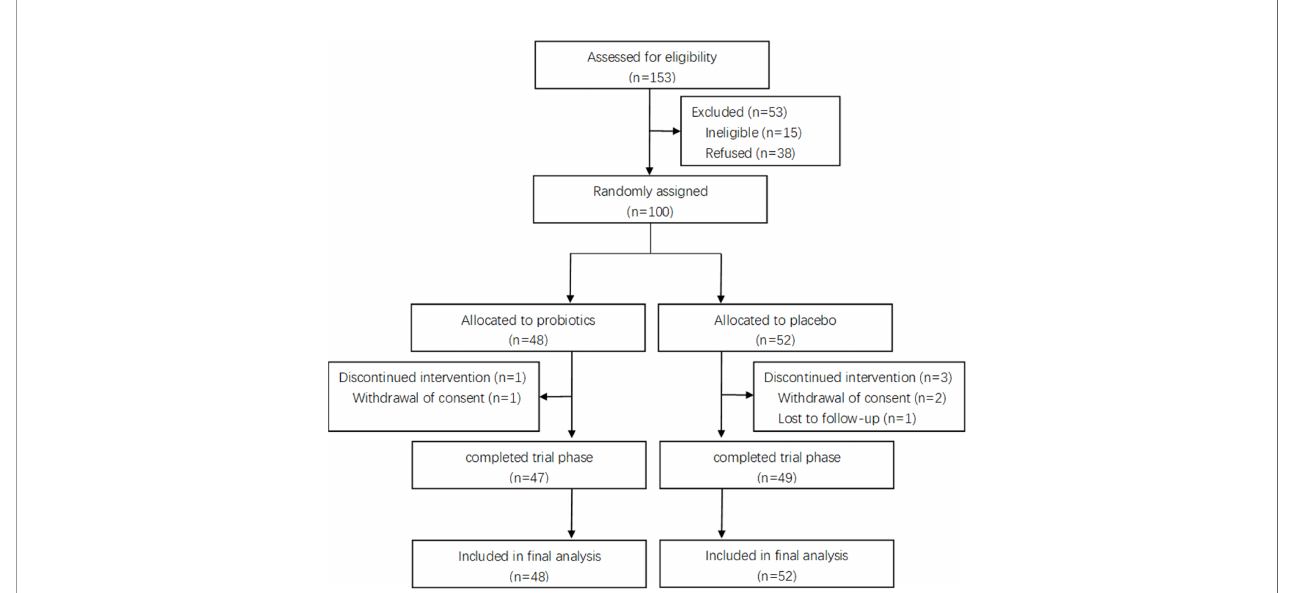
FIGURE 1 | Flowchart of the